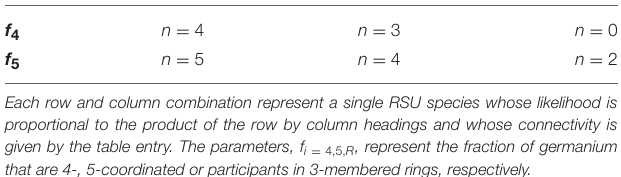
TABLE 1 | Coarse-grained connectivity of six possible RSUs found in alkali germanate glasses as discussed in the text. 1 − f R (cid:0) (cid:1)